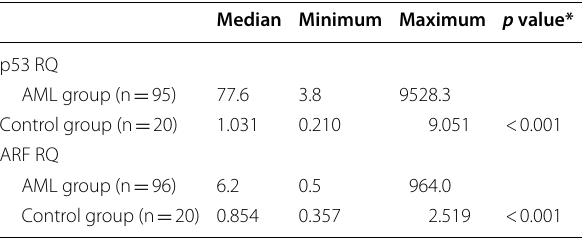
Table 1 Comparison between AML group and control groups